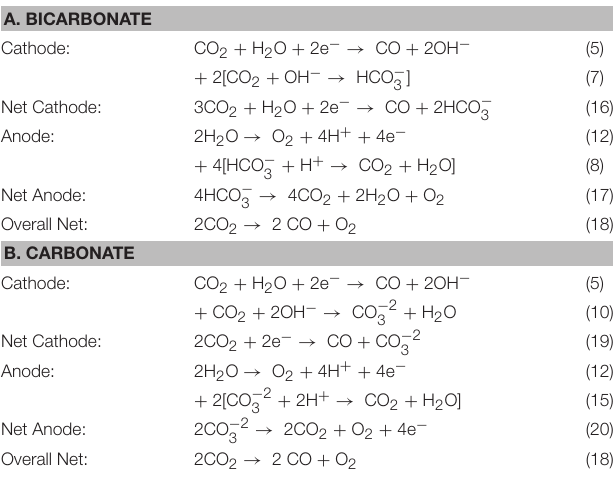
TABLE 3 | Summary of reactions having (A) bicarbonate or (B) carbonate as the selected mobile anion specie through the anion membrane in the CO 2